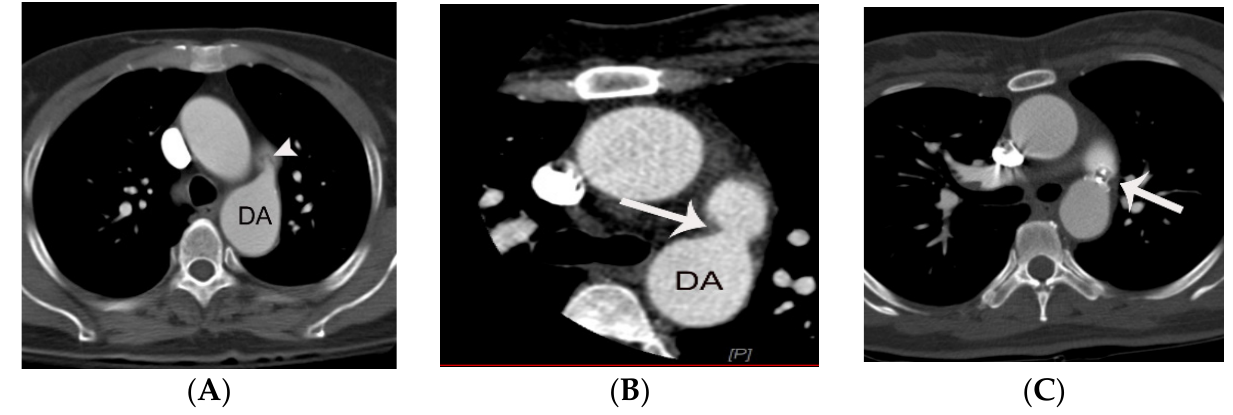
Figure 3. Representative cases of conically shaped PDA with a valve-like structure at the pulmonic end (arrow head on A ) and in its absence (arrow on B ). Amplatzer occluder device (arrow on C ) was successfully administered in a patient with conically shaped PDA (Same patient as B ).